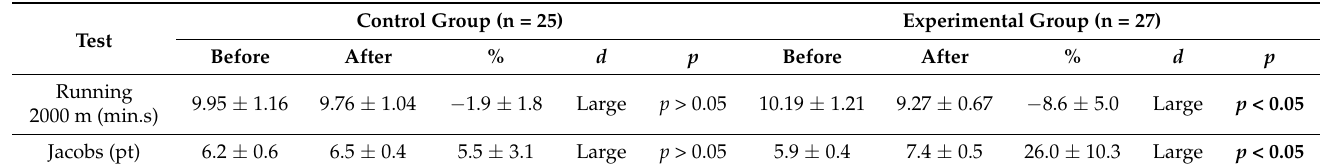
Table 3. The tests results for all